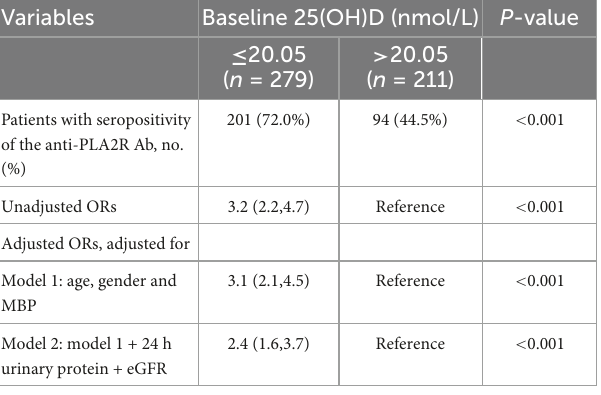
Table 3 ). When adjusting for sex, age, MBP, 24 h UP, and eGFR, patients with 25(OH)D ≤ 20.05 nmol/L still had 2.4 times higher probability for seropositivity of anti-PLA2R Ab (model 2, 95%CI 1.6, 3.7, P < 0.001) ( Table 3